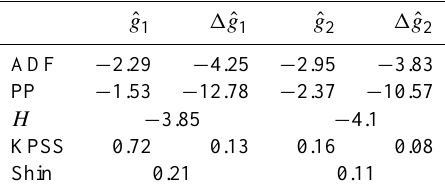
Table 2. Cointegration tests for anthropogenic anomalies. Table 3. Polynomial cointegration